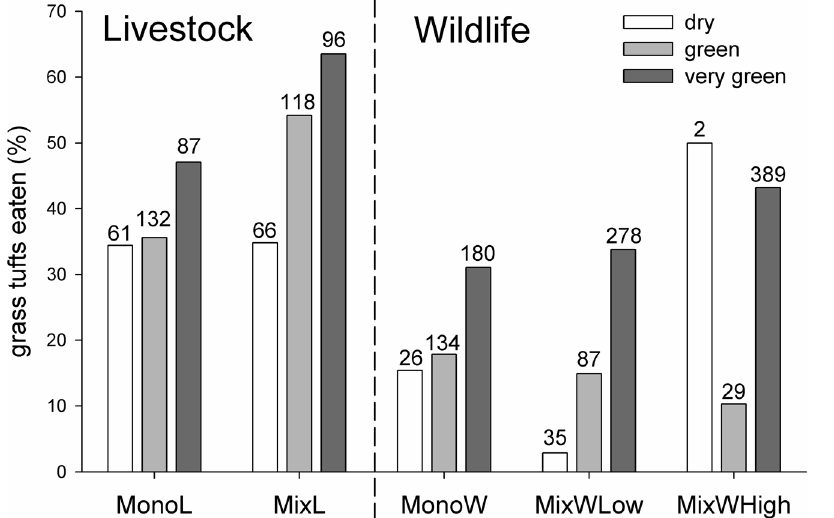
Figure 3. The average percentage of grazed grass tufts according to their absolute greenness values across the five study site types defined in Table 1. Numbers above bars indicate sample size.